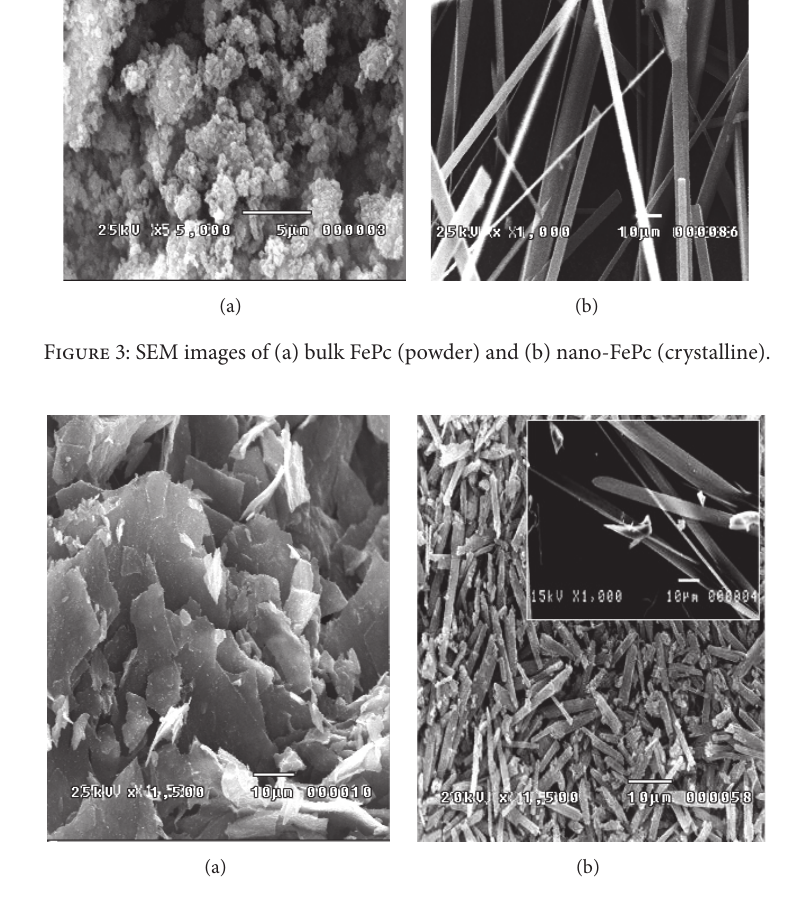
Figure 4: SEM image of (a) bulk [ Fe III ( Pc )( SCN )] 𝑛 and (b) nano- [ Fe III ( Pc )( SCN )] 𝑛 (inset: highlighting nanoscale